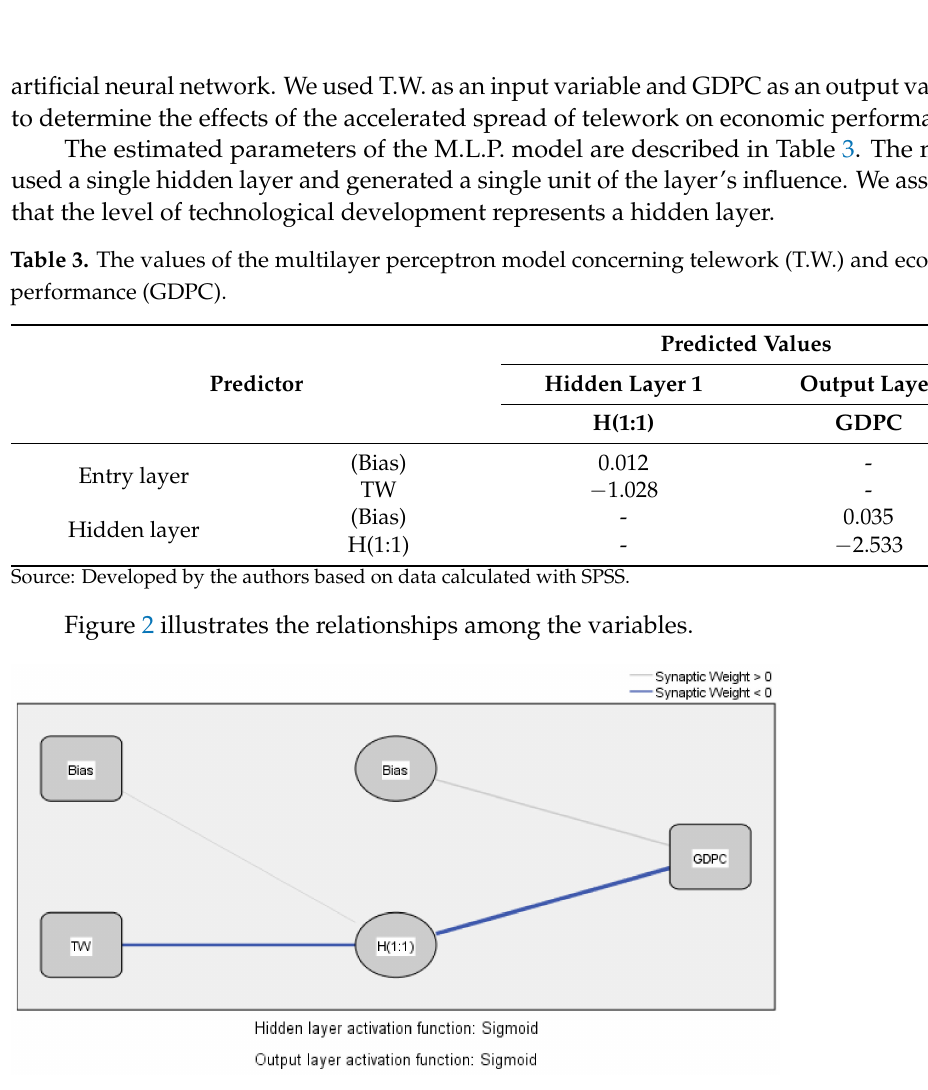
Figure 2. The multilayer perceptron model to identify the influences of telework (T.W.) on the economic performance (GDPC). Source: Developed by the authors using SPSS. Note: Bias—the influences of the exogenous factors; T.W.—telework; GDPC—economic performance; H(1:1)—the unit of the hidden